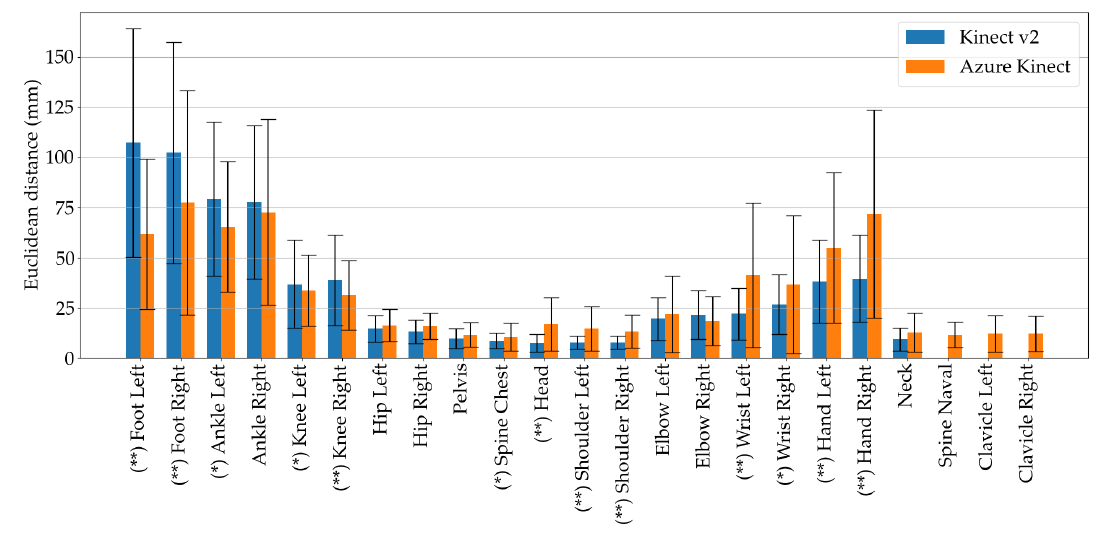
Figure A3. Spatial agreement between Microsoft Kinect v2 and Azure Kinect for 4.7 kmh − 1